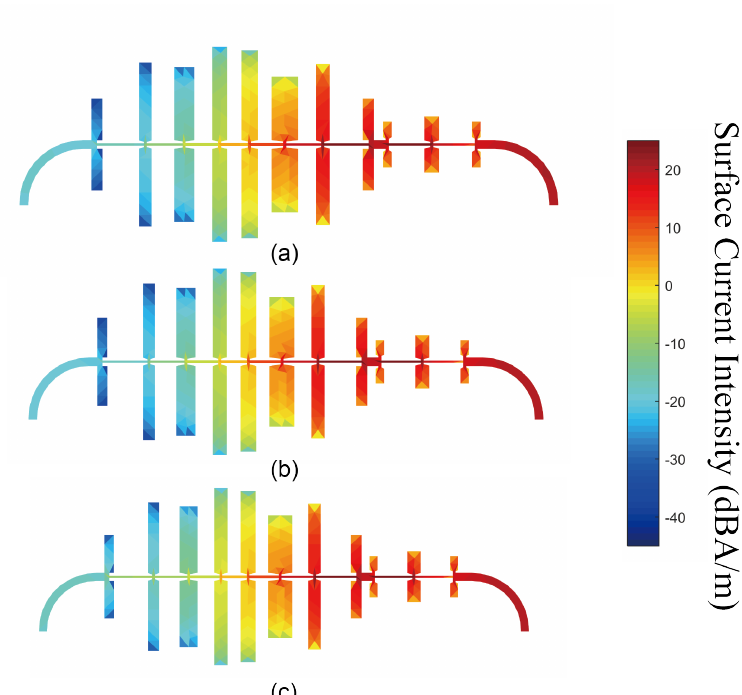
Figure 8. Surface current intensity of LPF at 2.9 GHz for voltage excitation on port 2 at 2.9 GHz calculated by different methods, ( a ) FEKO, ( b ) 2 − Level DCIM and ( c ) the proposed method.